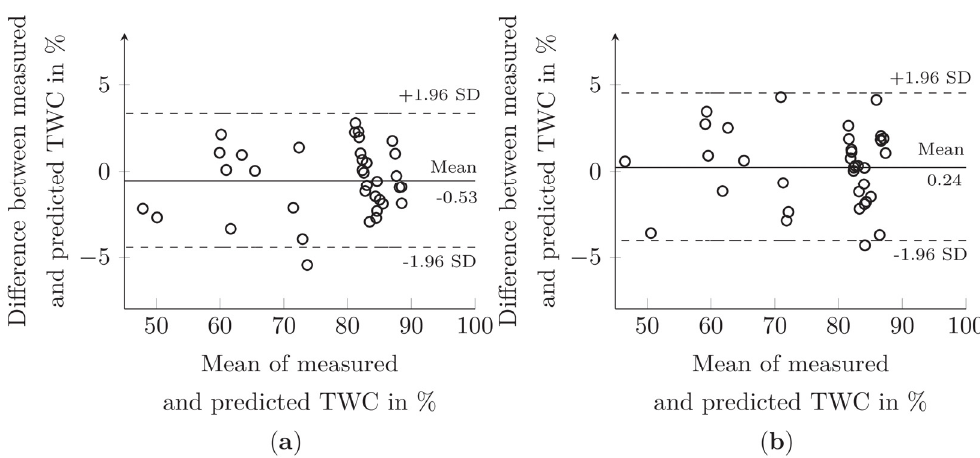
Figure 4. The Bland–Altman plot for ( a ) absorbance and ( b ) reflectance.